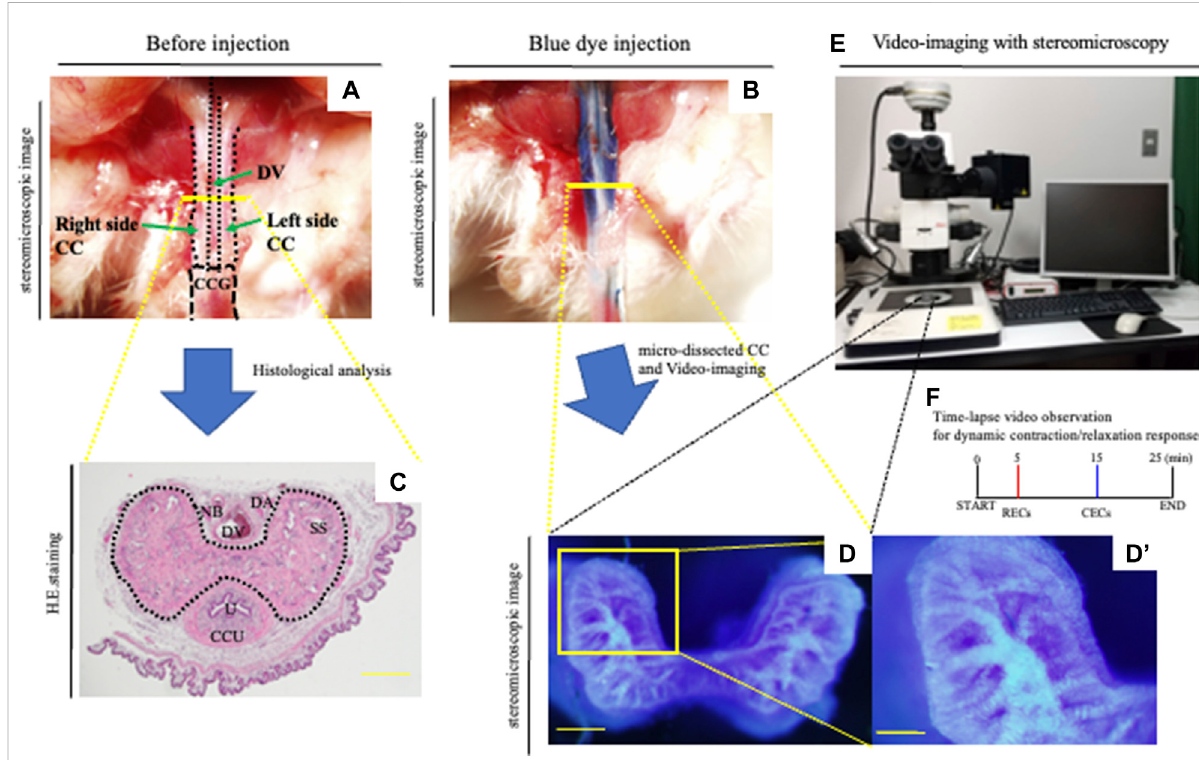
FIGURE 1 Novel invitro analysisoferectileresponses. (A,B) Afterthegeneralanesthesiaandbeingplacedinthesupineposition,theprepucewasremoved over the penis. A measure of 0.03 – 0.05 ml of the PB dye solution (25 mg/ml) was slowly administered left-intracavernously through the corpus cavernosum glandis (CCG) using a 29-gauge needle. (C) Image of hematoxylin – eosin staining of the CC. Mouse proximal penis possesses two corporal units (corpus cavernosum: CC, corpus cavernosum urethra: CCU). Many sinusoidal spaces in the CC are indicated inside the dotted line. Dorsal vein (DV), dorsal artery (DA), nerve bundle (NB), sinusoidal space (SS), and urethra (U). Scale bar 200 μ m. (D – F) Representative images of the PB dye-stained CC and a schematic diagram of the current experiment. The mouse with PB dye injection was harvested. The CC region was isolatedbymicrodissectionsremovingtheprepuce,dorsalvein,artery,andnerve.Subsequently,urethraandCCUwereremovedtogeneratetheCC explant. The micro-dissectedCC was cultured in HBSS. The area of thecytoskeleton containing collagen fi bers was ef fi ciently marked, and the dye- stainedregionswereobservedinsidethesinusoidalspace.Wetooktime-lapsepicturesevery10 stomonitorthecorporaltissueresponsesutilizinga stereomicroscope according to the observation criteria for dynamic relaxation/contraction (see Movie.1). This study is the fi rst direct experimental system visualizing the process of relaxation/contraction in a sinusoidal space. Time-lapse video observation criteria for dynamic relaxation/ contraction. Contraction-enhancing compounds; CECs (phenylephrine and endothelin-1) and relaxation-enhancing compounds; RECs (sodium